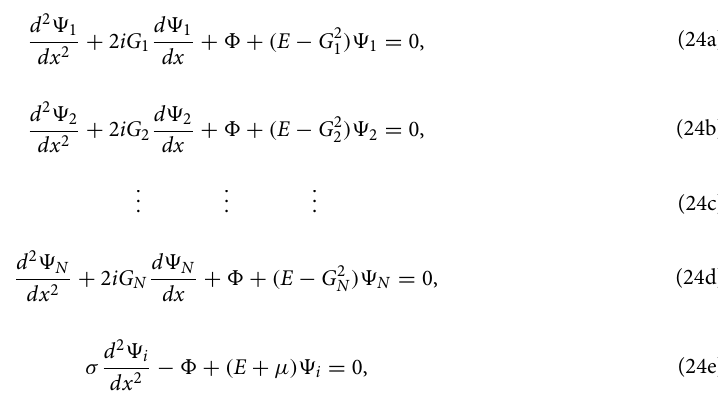
0.1 , ( b ) ξ 0.5 , ( c ) ξ 1 and ( d ) ξ 1.5 = = = =